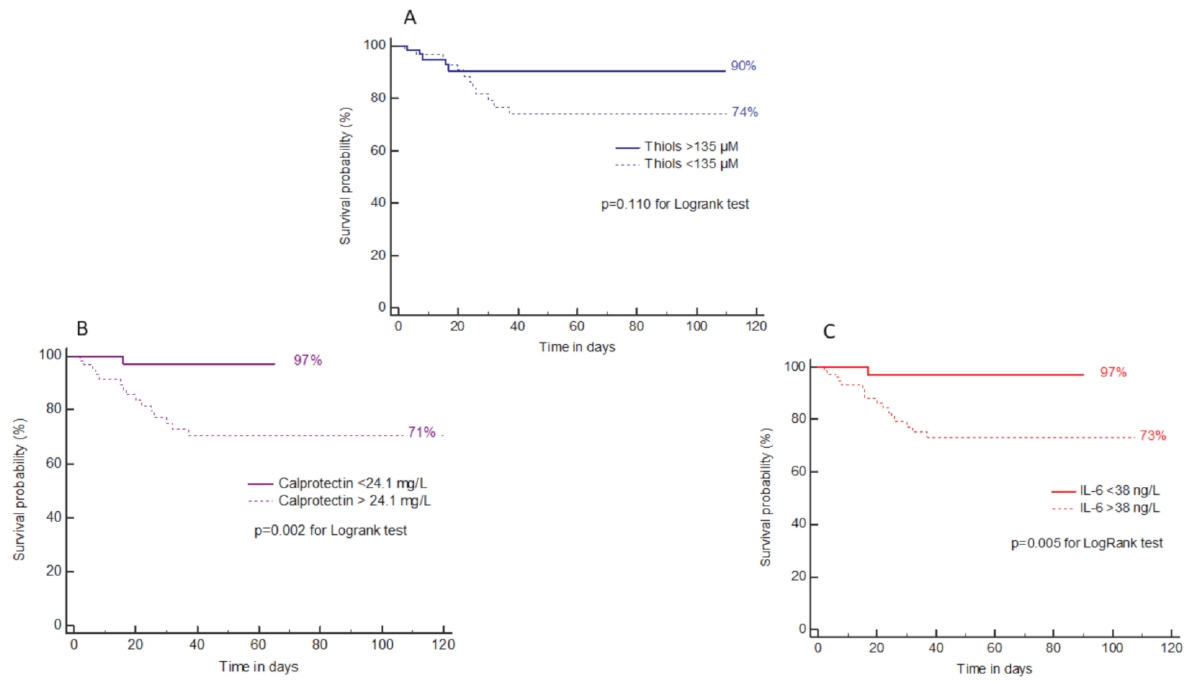
Figure 4. Survival curves according to thiol ( A ), calprotectin ( B ) and IL-6 ( C )